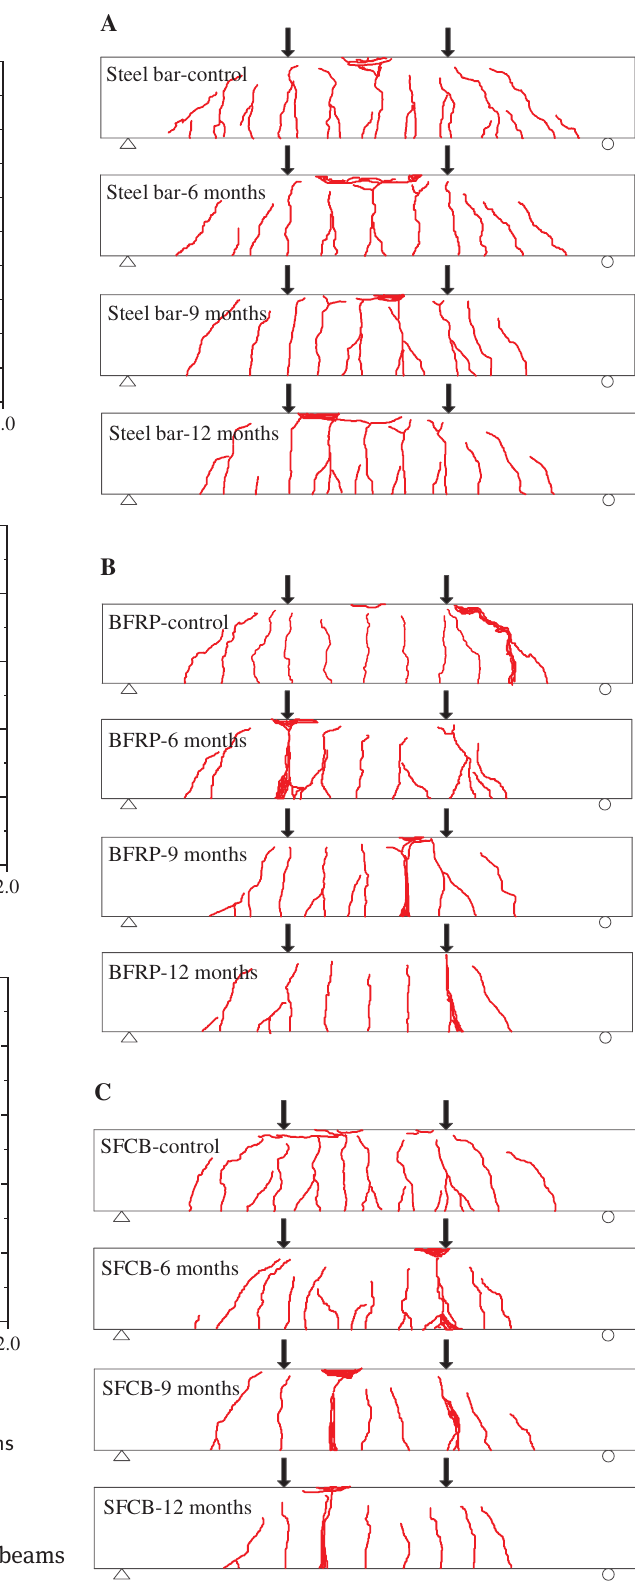
Figure 10: Crack distribution when the beams failed. (A) Steel bars RC beams, (B) BFRP bars RC beams and (C) SFCBs RC